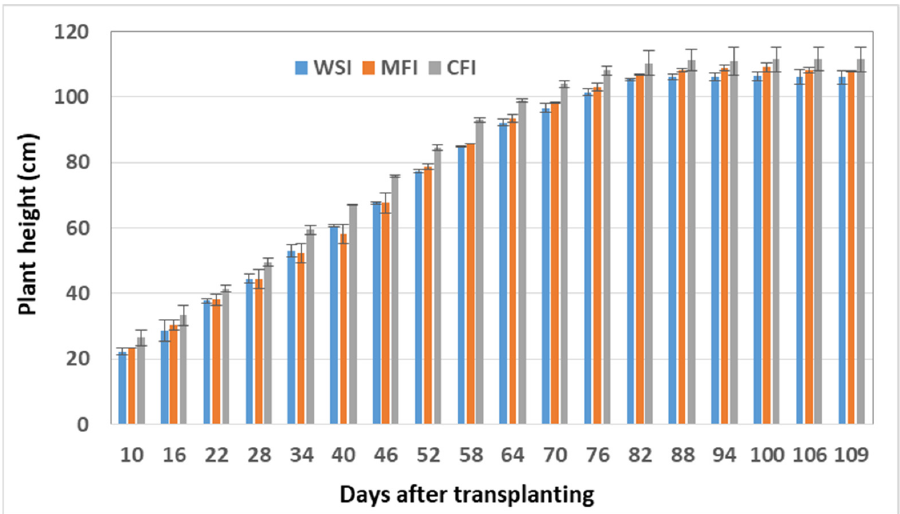
Figure 8. The Average plant height among the